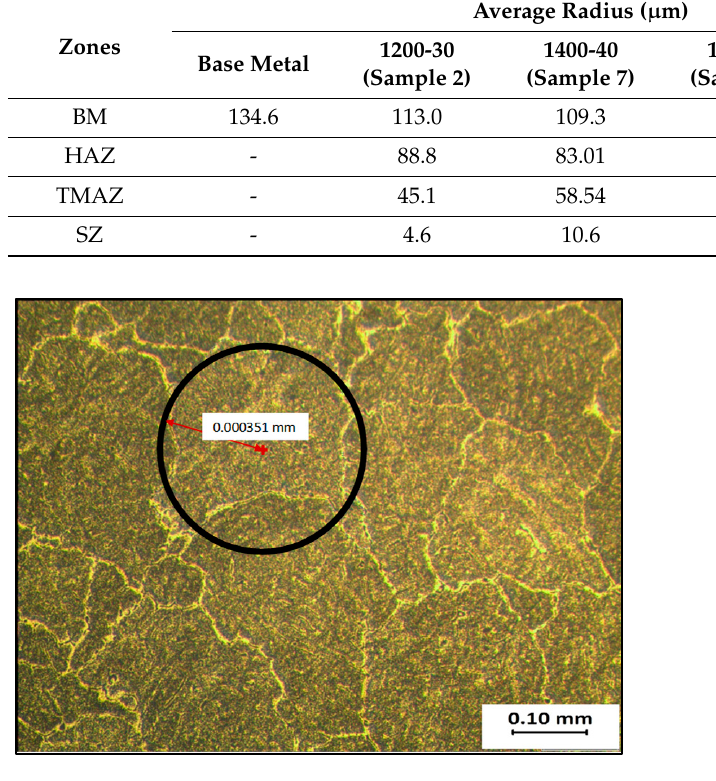
Figure 8. Grain size measurement (10×) for the base metal part of FSPed Sample 15.